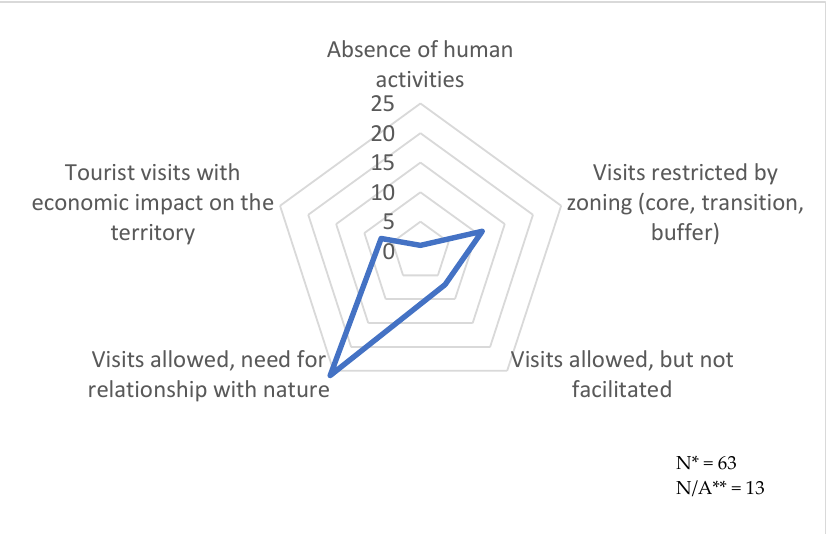
Figure 3. Distribution of responses concerning human traffic in wilderness areas according to the stakeholders interviewed (in absolute values). N*: total number of responses. N/A**: Not available (13 out of 63 stakeholders did not answer this question).